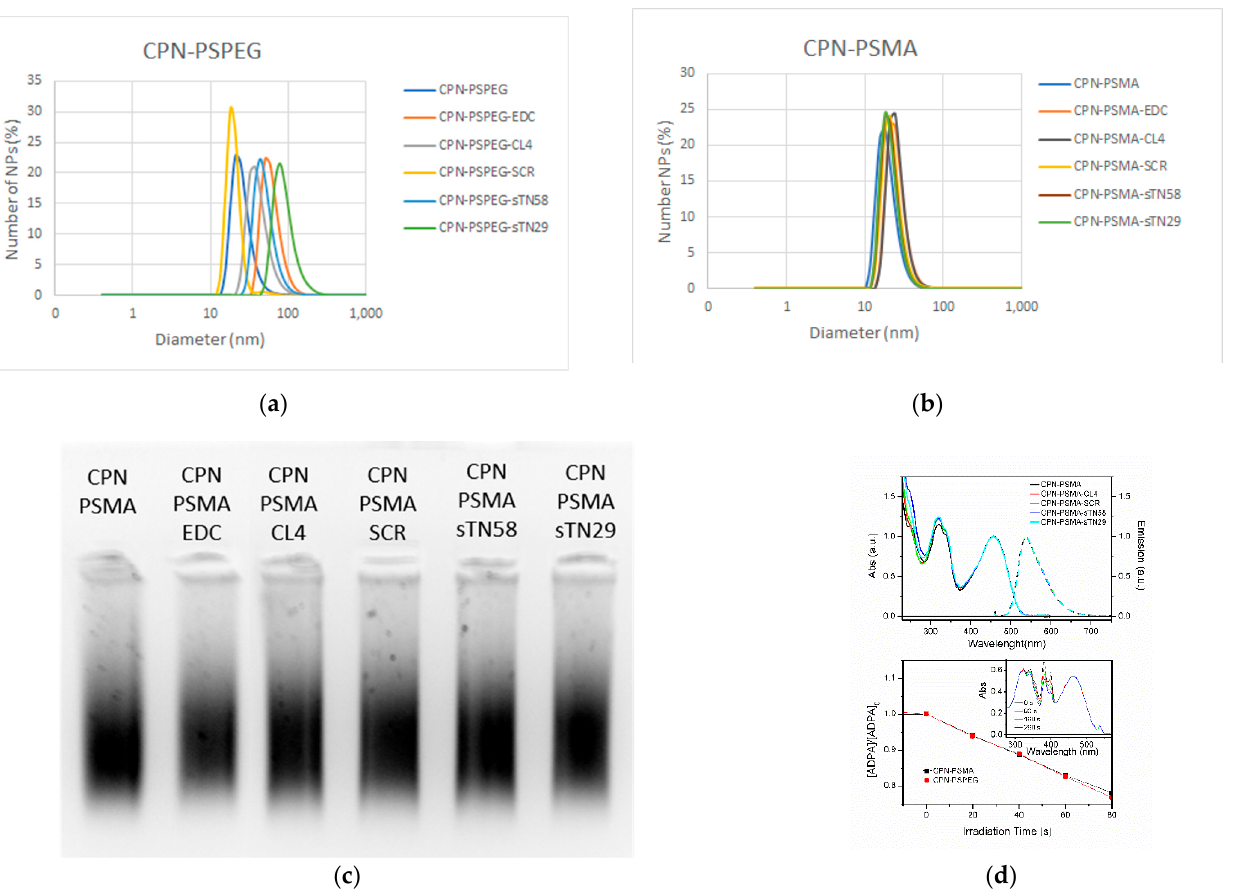
Figure 2. Characterization of aptamer-decorated CPNs. Dynamic light scattering data of CPN-PSPEG ( a ) and CPN-PSMA ( b ) before and after EDC COOH-activating reaction and aptamer conjugation. ( c ) Gel electrophoresis of different CPN-PSMA nanoparticles in 1.5% agarose gel. ( d ). Upper panel, absorption (solid lines, left axis) and emission (dashed lines, right axis) spectra of a different CPN without PtOEP decorated with CL4, sTN58, sTN29 and SCR aptamers. Lower panel CPNs photosensitized ADPA in the presence of air monitored at 400 nm. Insert: Absorption spectra of the ADPA solution (~4 × 10 − 5 M) in presence of CPNs (12 mg/L) at different irradiation times with a blue led.